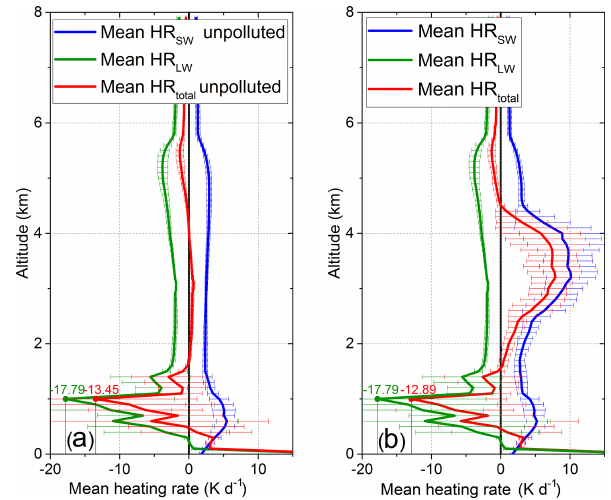
Figure 12. Average heating rate for “unpolluted” cases (a) and pol- luted situations (b) , over the sample area, from June to August 2008: shortwave HR (blue line), longwave HR (green line) and total HR (red line). The horizontal bars represent the standard